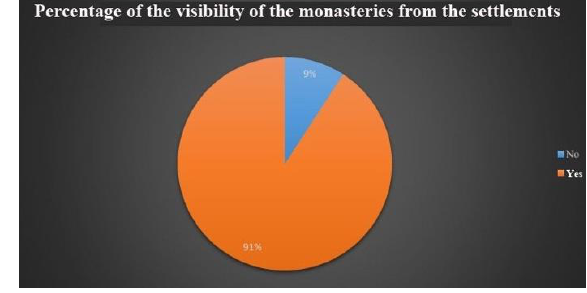
Figure 10 – Percentage of the monasteries from the settlements.